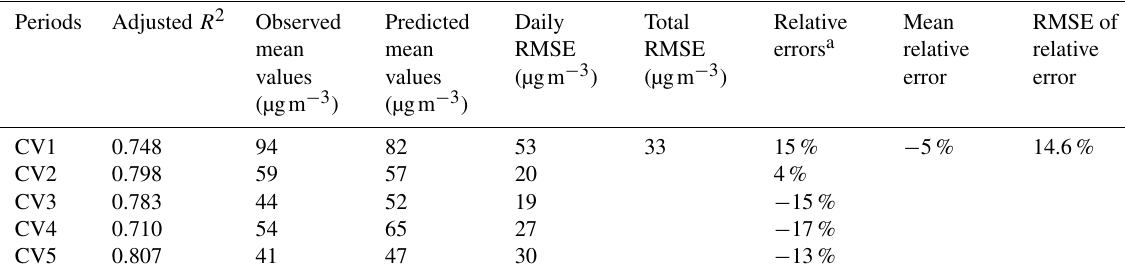
a Relative error = (predicted mean value – observed mean value)/predicted mean value ×